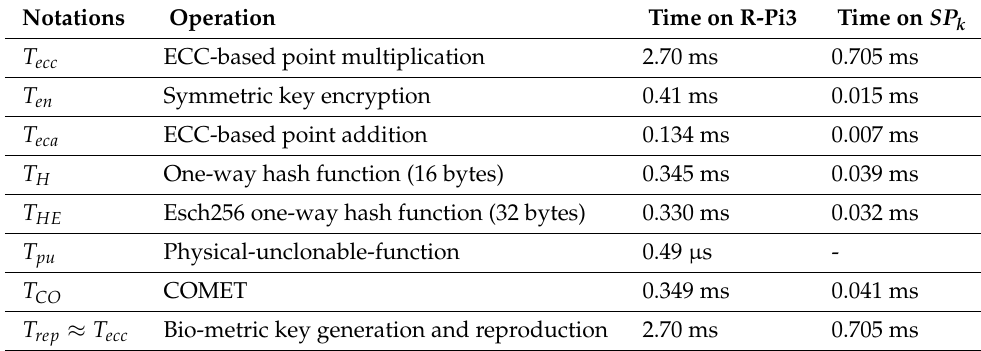
Table 4. Time complexity of different cryptographic operations.